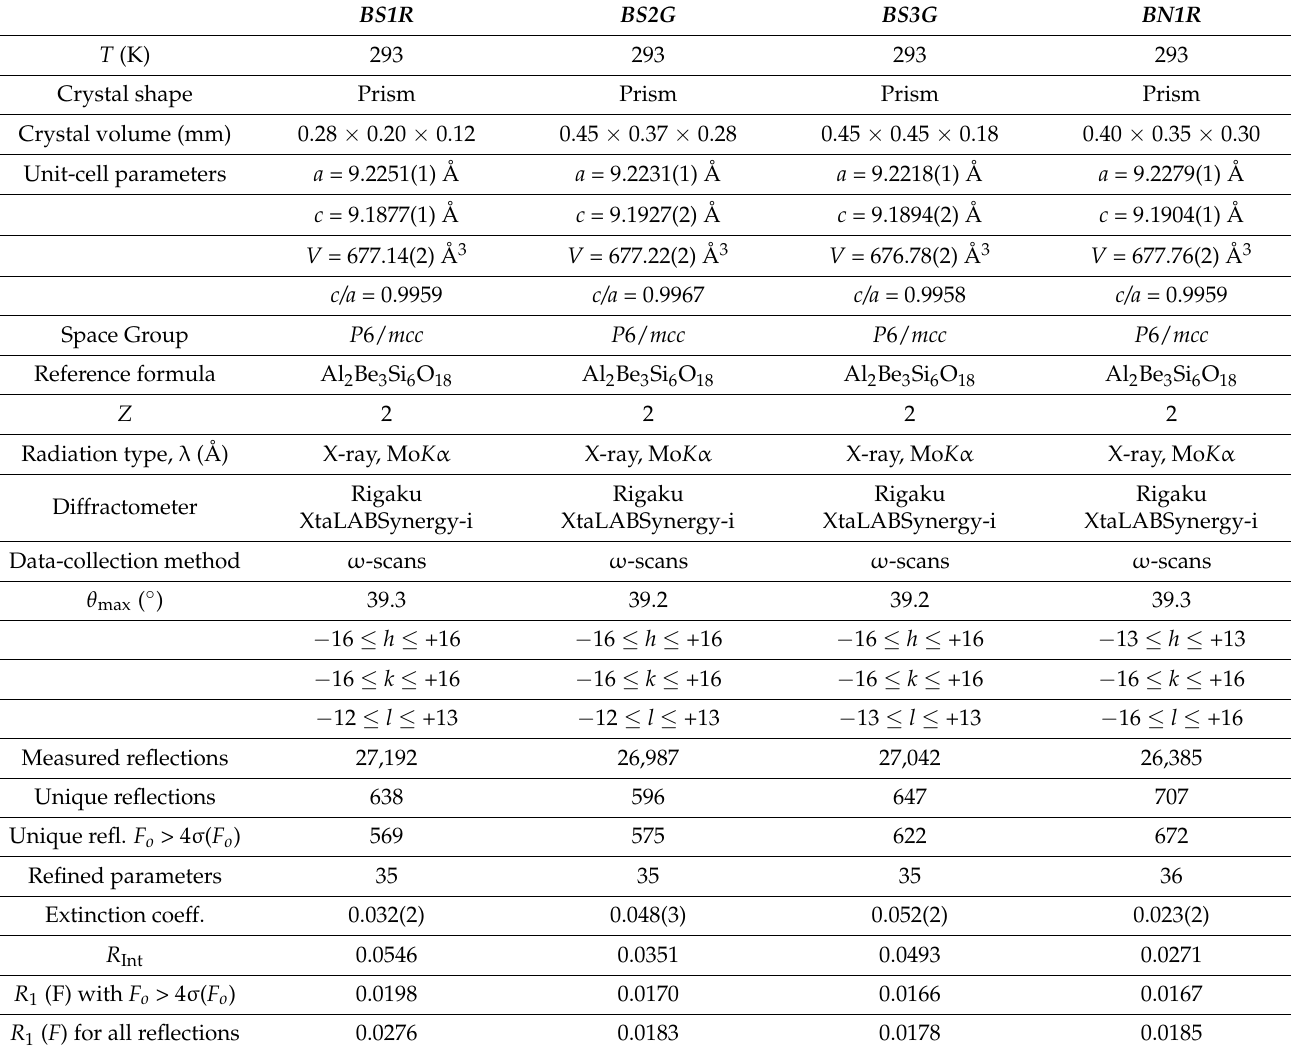
Table 3. Details pertaining to the X-ray data collections and refinements of